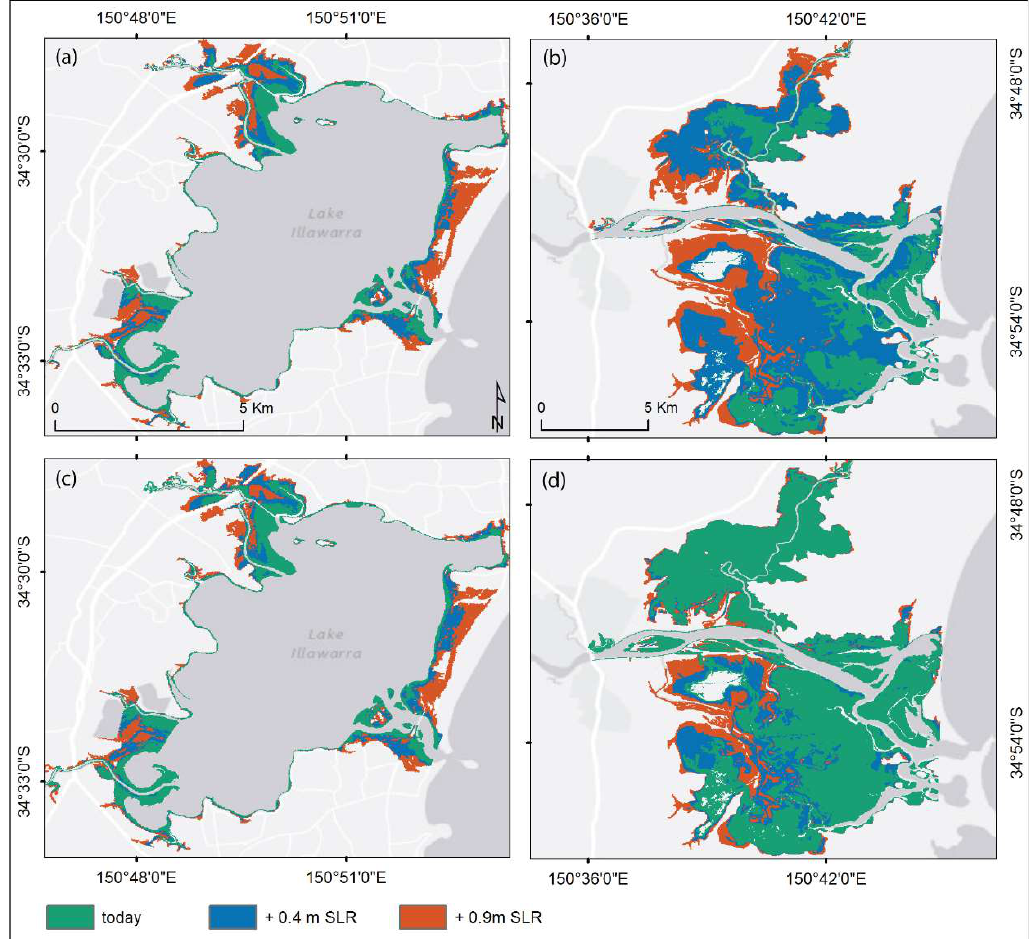
Figure A1. Maximum inundation extents of storm surge simulations for present conditions and SLR scenarios at Lake Illawarra ( a ) and the Shoalhaven Estuary ( b ), as well as the extent of compound flooding simulations ( c , d ) for the respective sites.